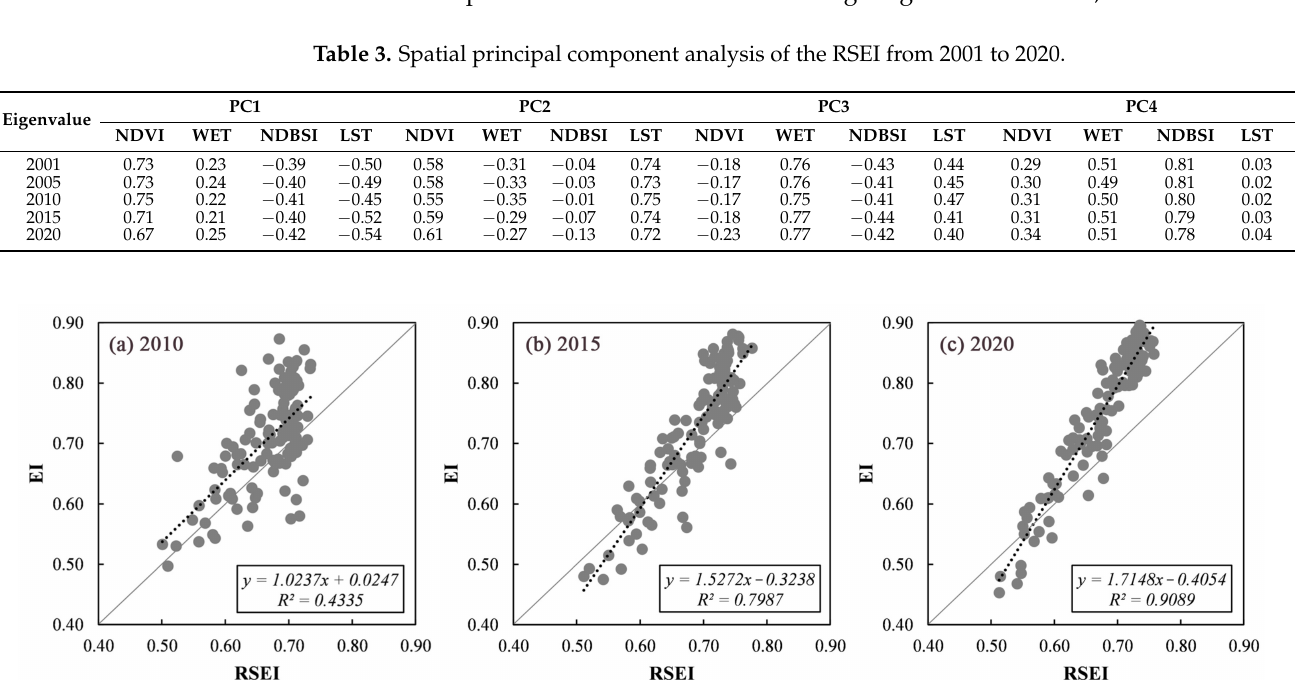
Figure 8. Relationship between the EI and RSEI of Guangdong Province in 2010, 2015 and